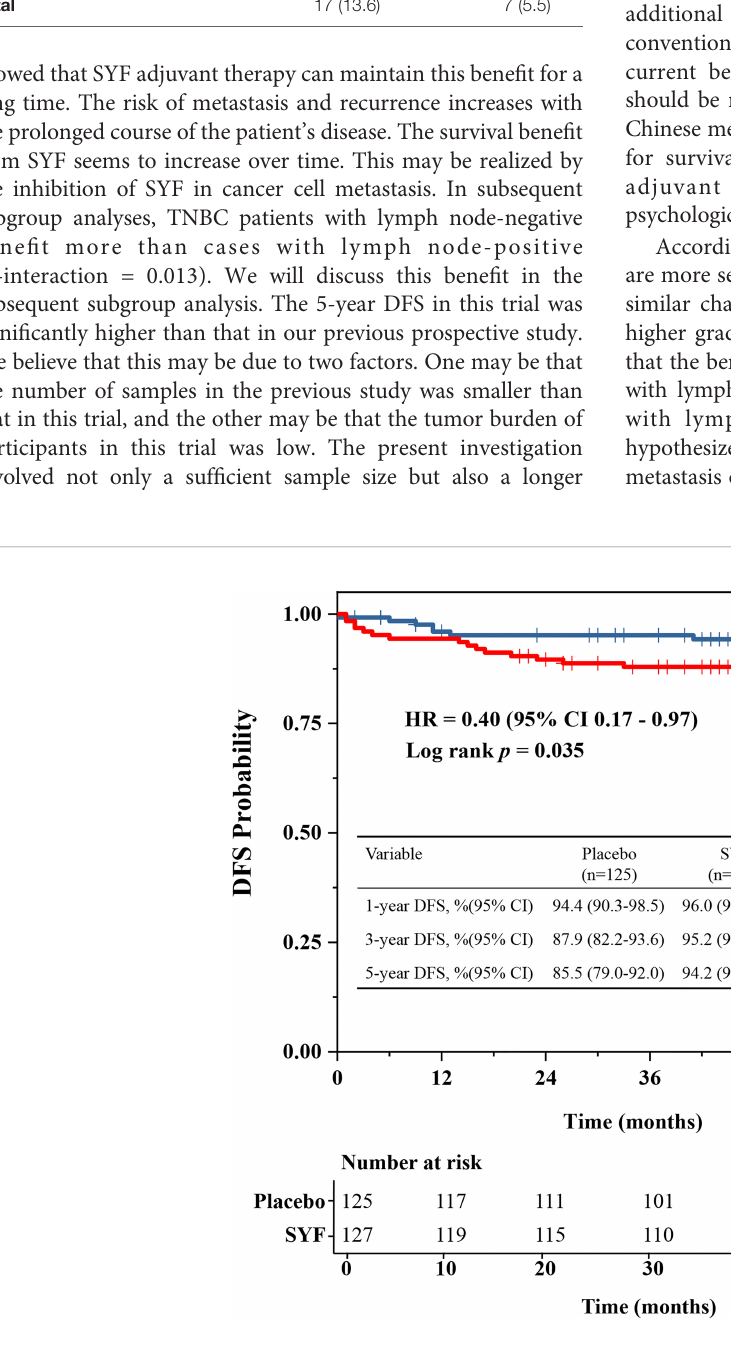
FIGURE 2 | Disease-Free